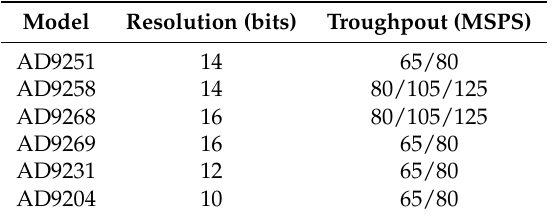
Table 3. Analog Devices ADC converters for a resolution higher than 10 bits and throughput higher than 60